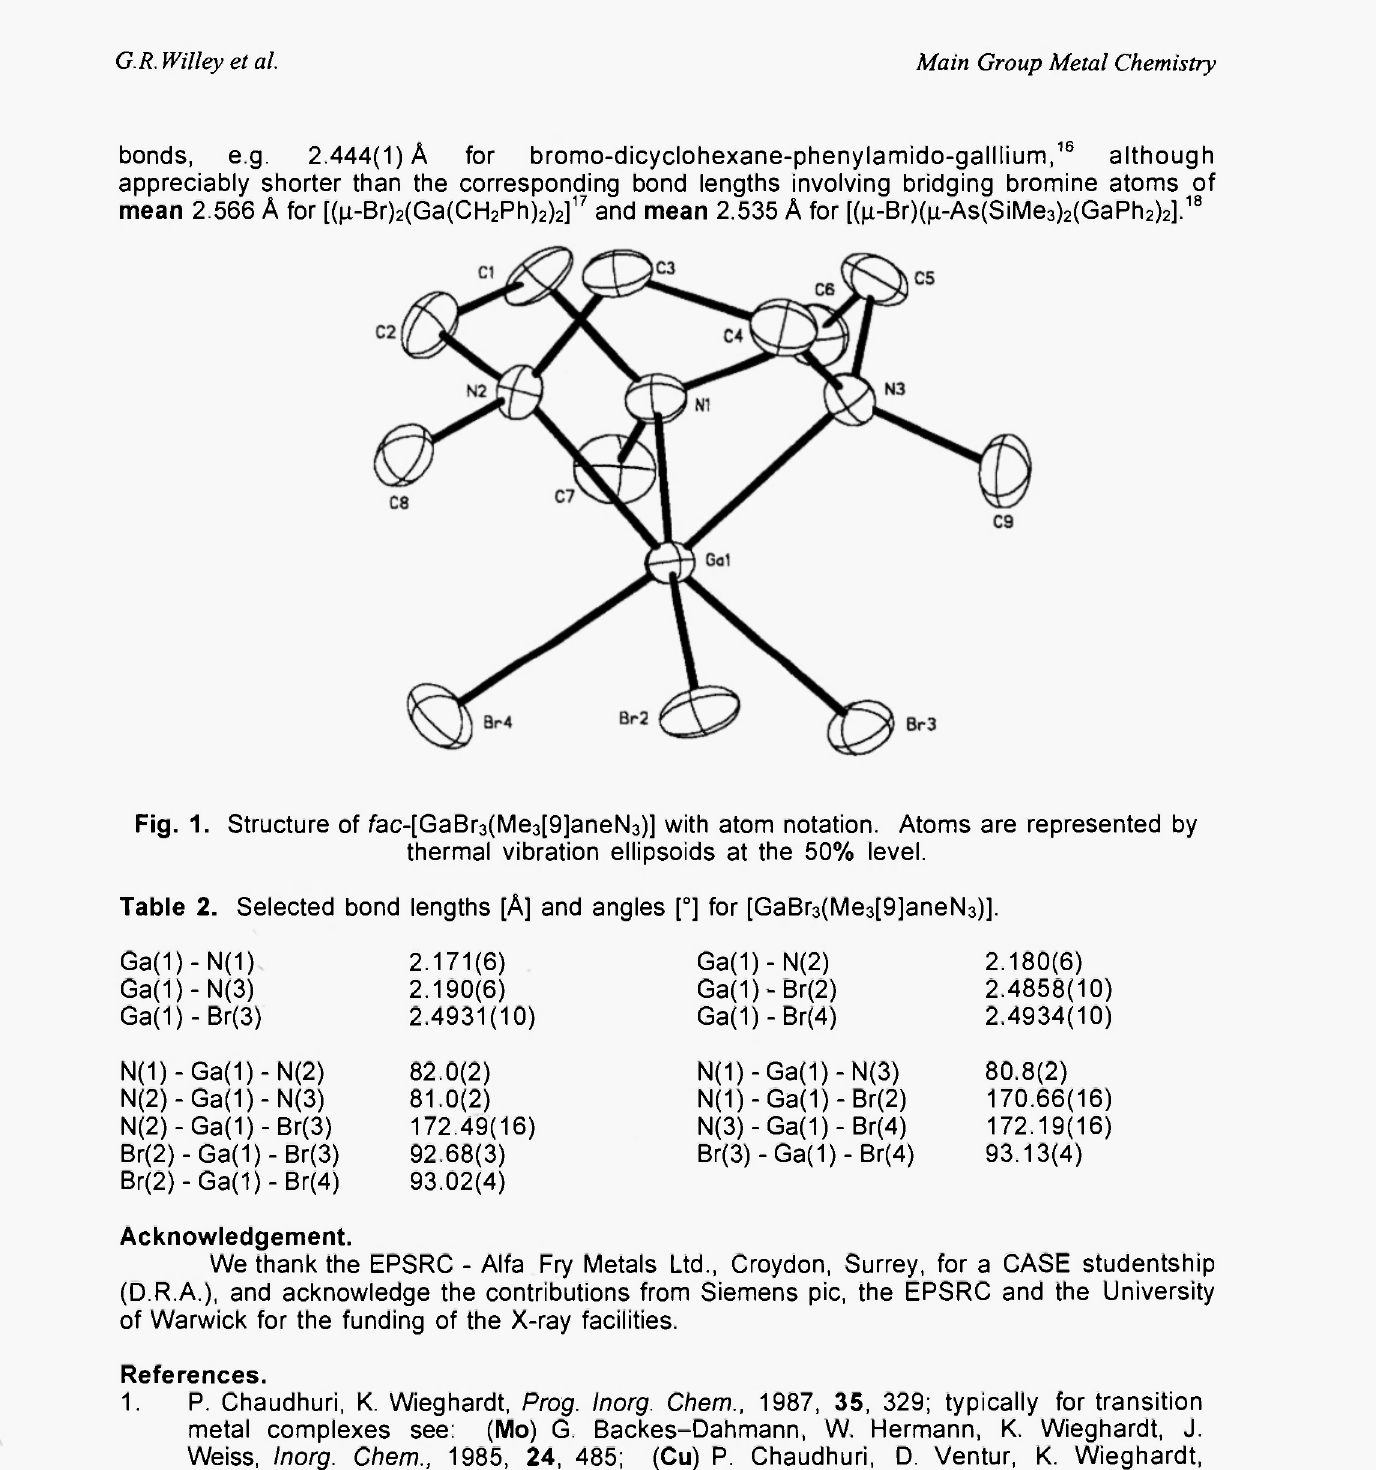
Fig. 1. Structure of fac-[GaBr 3 (Me 3 [9]aneN 3 )] with atom notation. Atoms are represented by thermal vibration ellipsoids at the 50% level. Table 2. Selected bond lengths [A] and angles [°] for [GaBr 3 (Me 3 [9]aneN 3